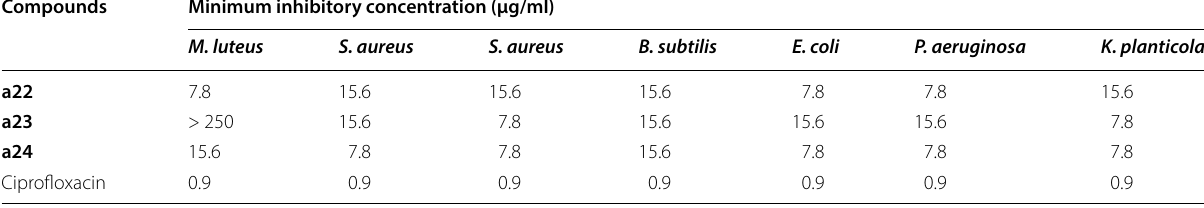
Table 11 MIC values of the compounds a22, a23 and a24 Compounds